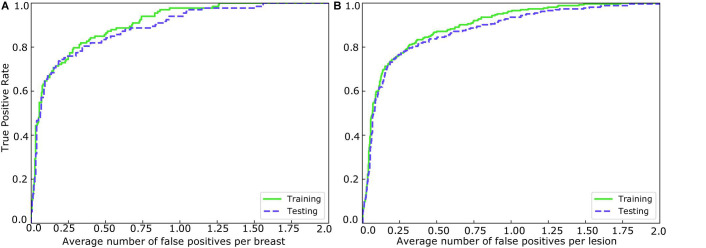
FROCs for the training and testing sets in (A) breast-based and (B) lesion-based mass detection.